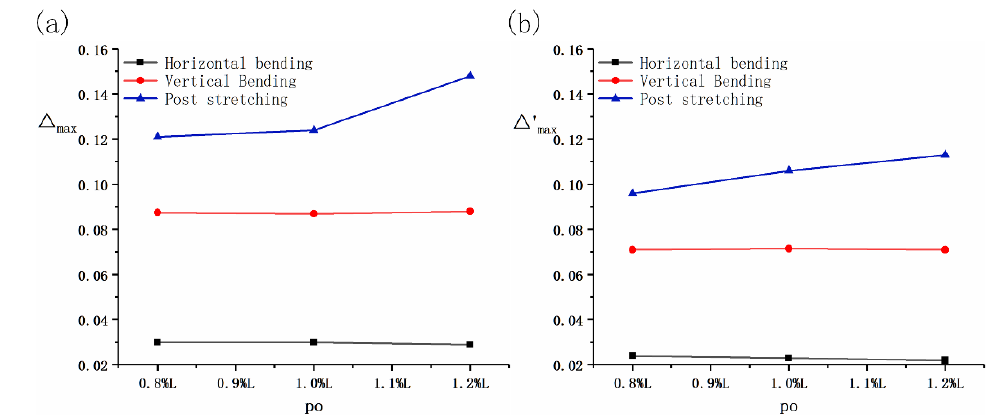
Figure 6. Effect of the post-stretching on thinning. ( a ) Outer web. ( b ) Inner web. The effect of the pre-stretching on thinning is as shown in Figure 7. The thinning degree of the outer web and the inner web increases with the increasing of the pre-stretching amount. When the pre-stretching amount is 0.8% after completion of post-stretching, the outer web is thinned by 0.12 mm and the inner web is thinned by 0.094 mm.